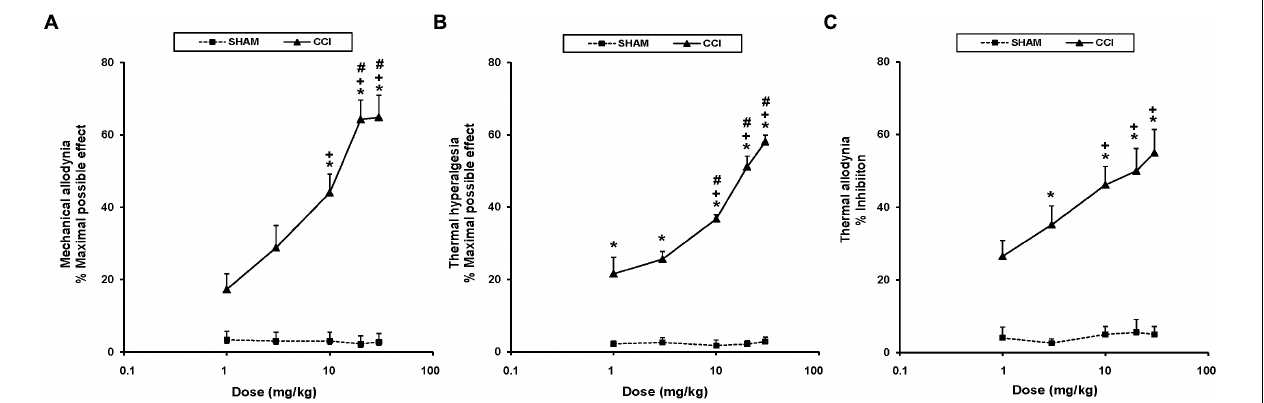
FIGURE 2 | Effects of UFP-512 on the mechanical allodynia, thermal hyperalgesia, and thermal allodynia induced by CCI. The effects of the intraperitoneal acute administration of different doses (logarithmic axis) of UFP-512 on the mechanical allodynia (A) , thermal hyperalgesia (B) , and thermal allodynia (C) induced by sciatic nerve injury in the ipsilateral hind paw of CCI-injured (continuous lines) or sham-operated mice (discontinuous lines) are represented. UFP-512 was administered 1 h before testing. For each test and dose evaluated, ∗ indicates significant differences vs. their respective effects in sham-operated mice, + indicates significant differences vs. the effects produced by 1 mg/kg of UFP-512 in CCI-injured mice, and # indicates significant differences vs. the effects produced by 3 mg/kg of UFP-512 in CCI-injured mice ( P < 0.05; one-way ANOVA, followed by the Student–Newman–Keuls test). Data are expressed as mean values of maximal possible effect (%) for mechanical allodynia and thermal hyperalgesia, and inhibition (%) for thermal allodynia ± SEM; n = 6 animals per dose.